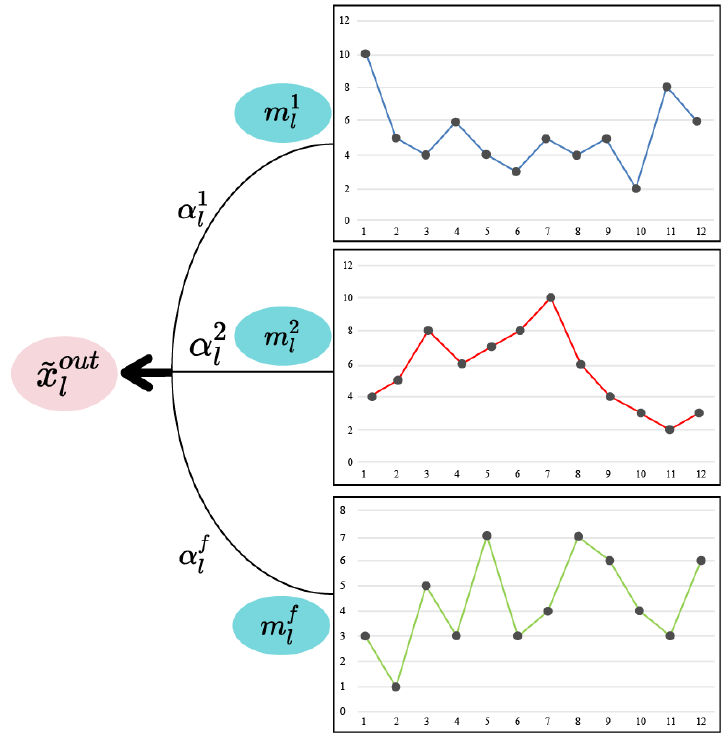
Figure 6. External heterogeneous data fusion